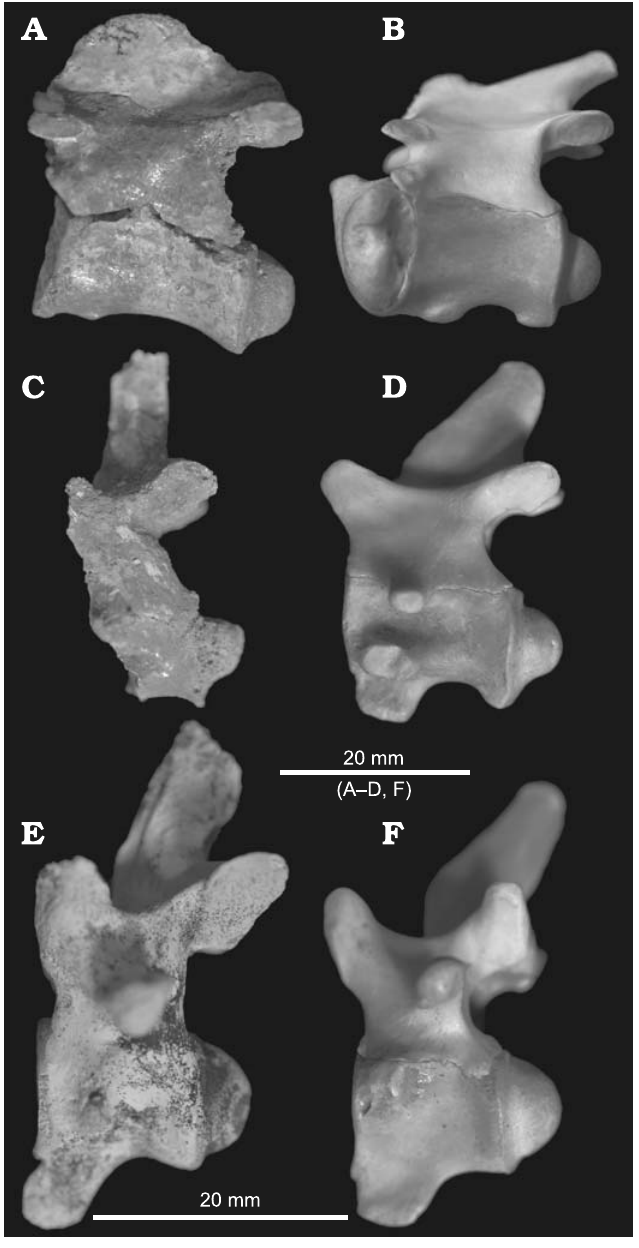
Fig. 3. Vertebral morphology of mekosuchine crocodile Mekosuchus white- hunterensis Willis, 1997 ( A , C , E ) from White Hunter Site, Riversleigh World Heritage Area, northwestern Queensland, Australia, late Oligocene compared with Crocodylus johnstoni Krefft, 1873 ( B , D , F ) from upper Herbert River, northeastern Queensland, Australia, late Pleistocene– Holocene. Axis vertebrae ( A , QM F56039; B , AR 17683). Third cervical vertebrae ( C , QM F56040; D , AR 17683). Eighth cervical vertebrae ( E , QM F56322; F , AR 17683). All in left